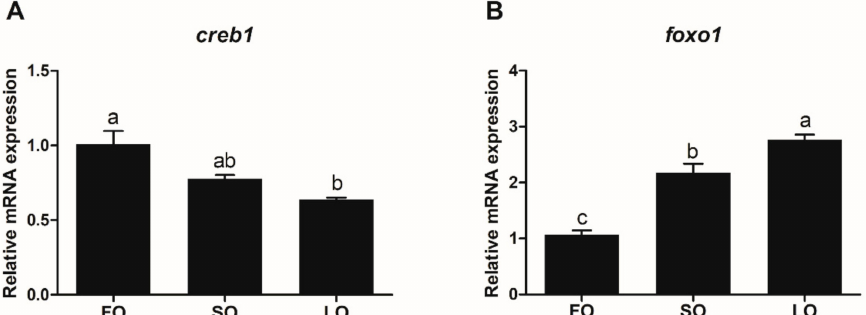
Figure 8. The transcriptional expression of creb1 ( A ) and foxo1 ( B ) in the liver of rainbow trout that were fed diets containing fish oil (FO), soybean oil (SO), and linseed oil (LO). The expression in FO was selected as normalization. Data were presented as means ± S.E.M. (n = 3). Means that share the same superscript letter are not significantly di ff erent ( p >